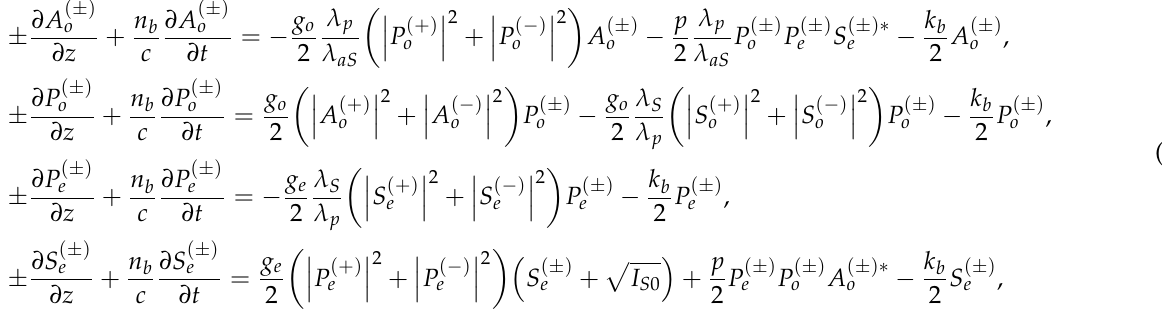
Figure 8. The simulation results of the mode ‐ locked laser oscillation for the shutter with t open = 2 ns at ( a ) φ = 17°, ( b ) φ = 27°, and ( c ) φ = 37°.